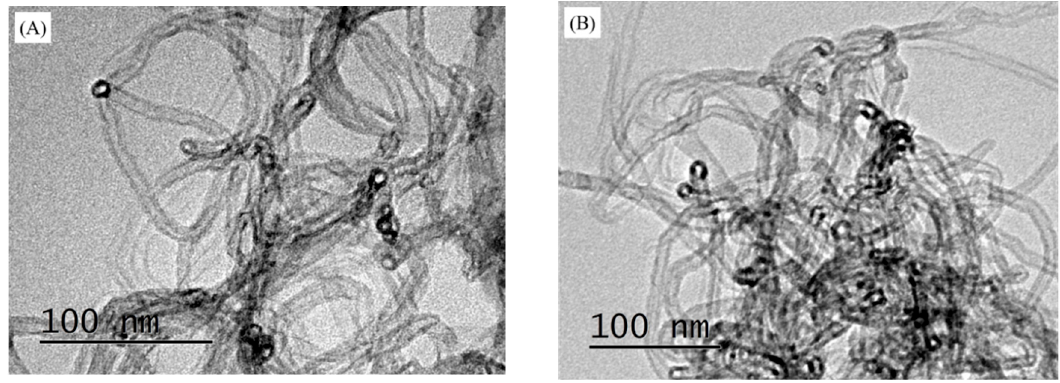
Figure 2. Morphologies of MWCNTs in uncured ( A ) ESC with 0.6 wt% MWCNT and ( B ) BrC with 0.6 wt% MWCNT on the steel substrates.